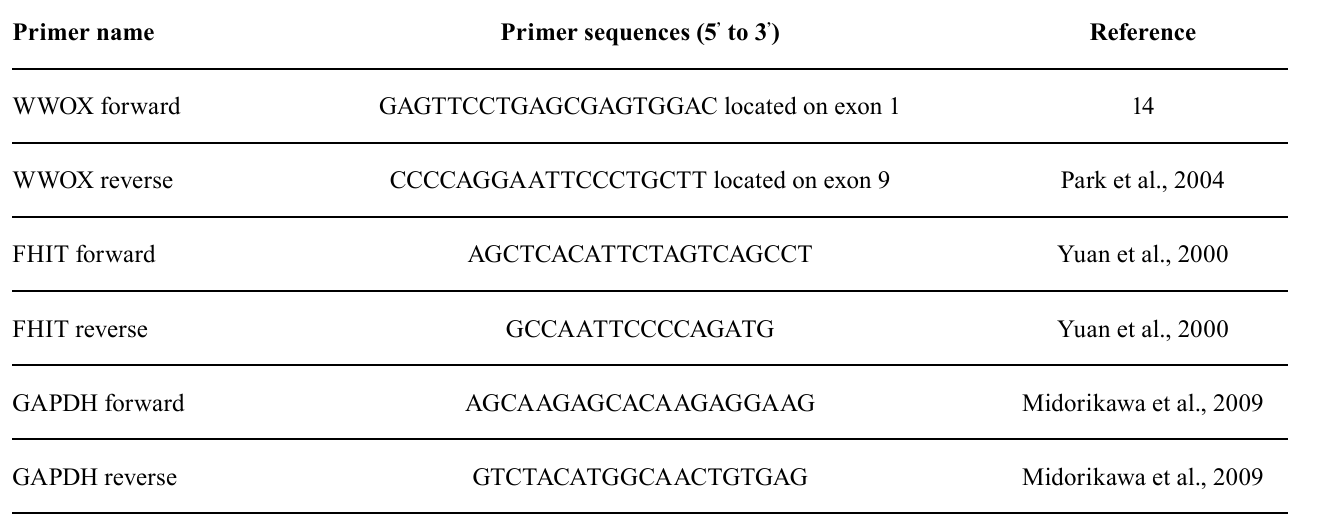
TABLE I – R eal-time PCR primers used in the